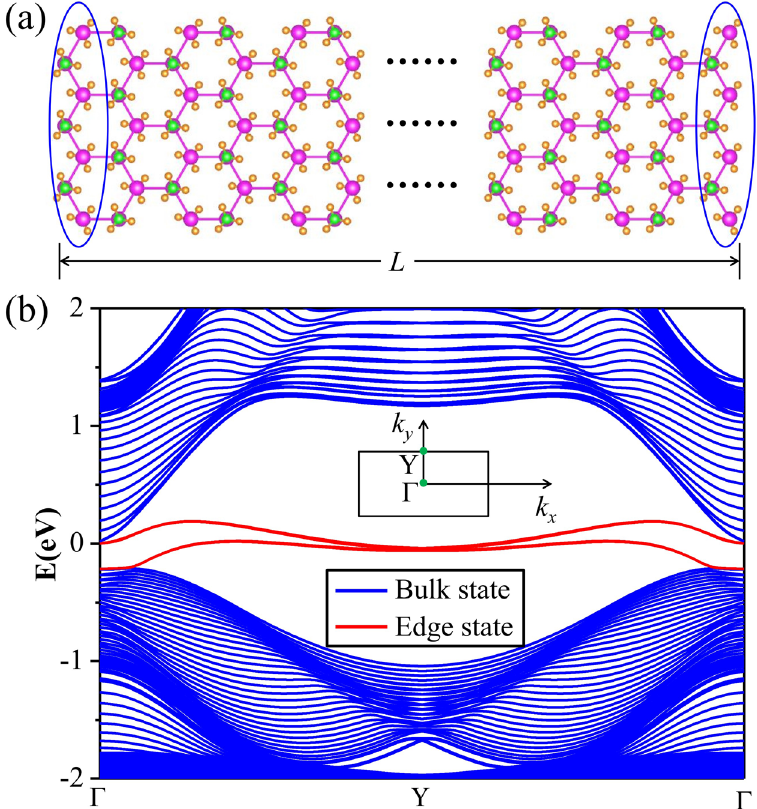
Figure 3. ( a ) Atomic structure of nanoribbon of SnCH 3 with zigzag edges. L is the width of nanoribbon. ( b ) Corresponding edge states of SnCH 3 with 1D Brillouin zone indicated in the inset with Γ = 0 and Y = π / L . The Fermi level is set to